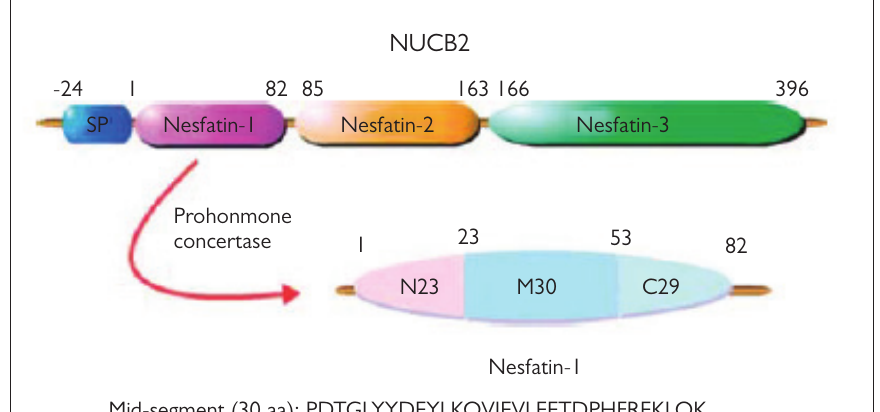
Figure 1. Structure of NUCB2 protein and Nesfatin-1 formation.